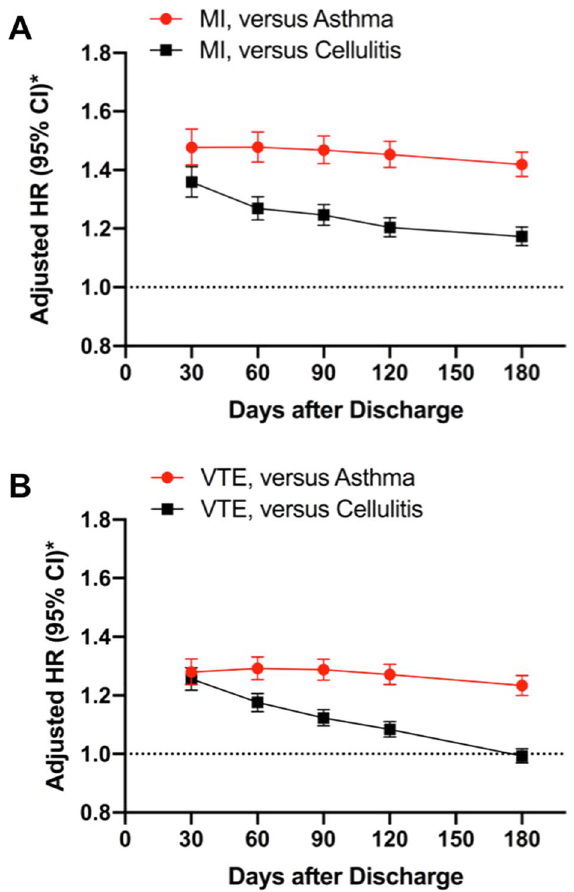
Figure 2. Adjusted hazard of readmission for myocardial infarction [MI] (Panel A ) and venous thromboembolism [VTE] (Panel B ) over time after hospital discharge among patients with respiratory infection versus those with asthma (red lines) and cellulitis (black lines). *Cox proportional hazards analyses were adjusted for clinical covariates including age, sex, tobacco use, hypertension, dyslipidemia, diabetes